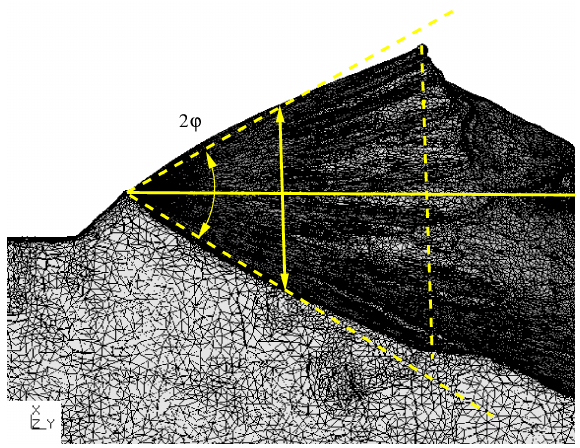
Figure 10. Estimating the deflection angle from the triangulation of the fractured